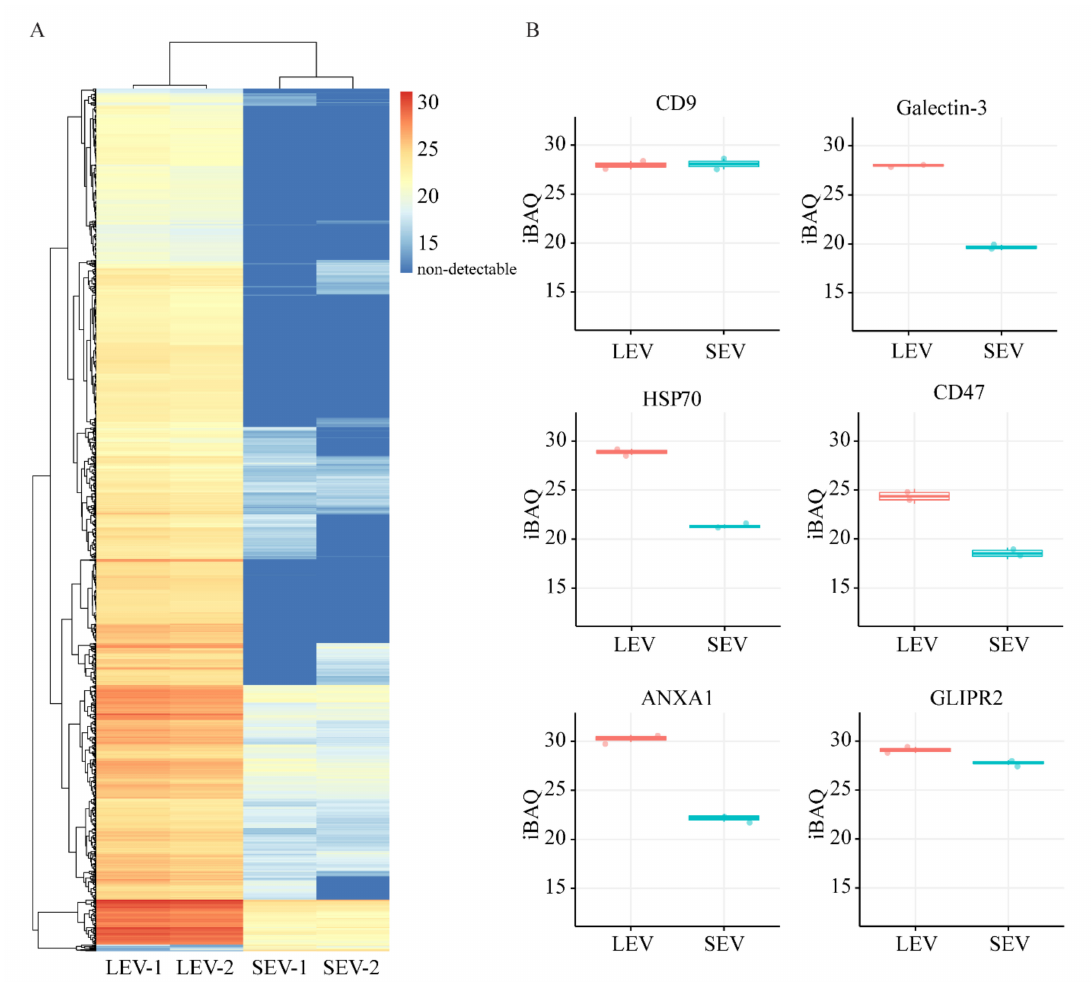
Figure 3. ( A ) IBAQ heatmap for all 1557 proteins that were detected either in LEV and / or SEV in both experiments (see Figure 1A). Color code key on the right indicates iBAQ values. Red color is corresponding to relatively high abundance of proteins, darkest blue indicates absence of protein. ( B ) IBAQ values of six selected proteins in LEV and SEV that were also compared by immunoblotting (see Figure